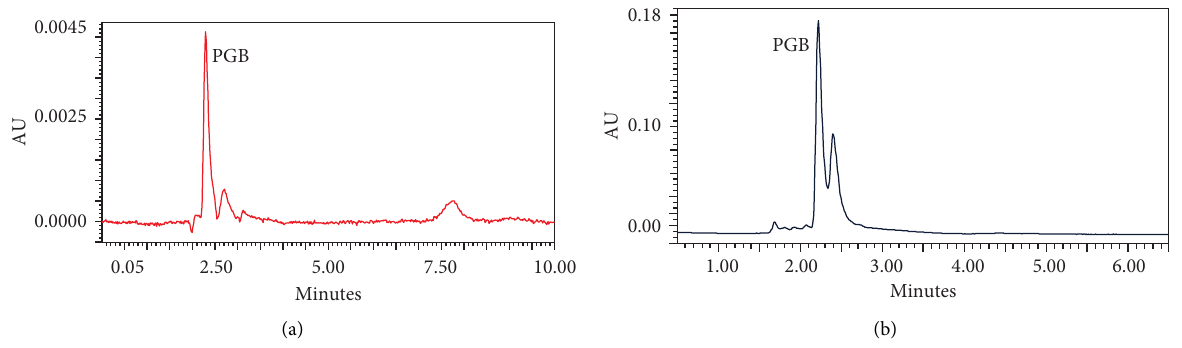
Figure 5: HPLC chromatogram of pregabalin (a) before extraction at 5 µ L spiked sample and (b) after SPEEK extraction of drug-free urine sample spiked at 0.1 µ